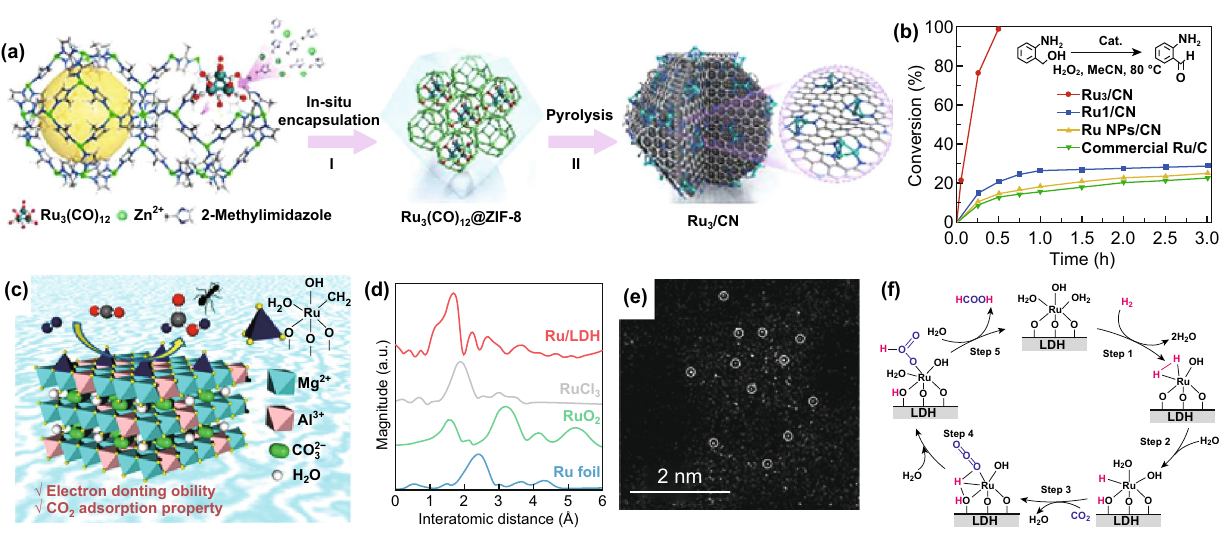
Fig. 11 a Illustration of the preparation process of Ru 3 /CN. b Conversion (%) of 2-aminobenzylalcohol versus time for Ru 3 /CN, Ru 1 /CN, Ru NPs/CN, and commercial Ru/C. c Schematic illustration of the hydrogenation. d Ru K-edge FT-EXAFS spectra. e HAADF-STEM image of Ru/LDH. f Possible reaction pathway for CO 2 hydrogenation to produce formic acid with a Ru/LDH catalyst. Panels are reproduced from Refs. [151, 174] with permission. Copyright 2017 American Chemical Society